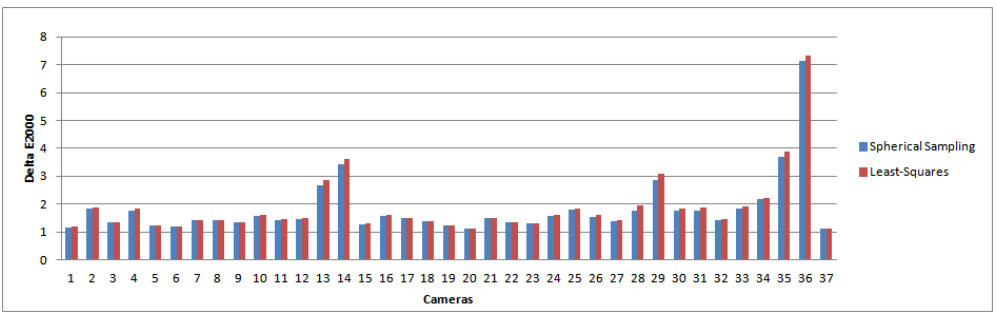
Figure 4. ∆ E error for the different cameras. In blue: ∆ E 00 error for the least-squares